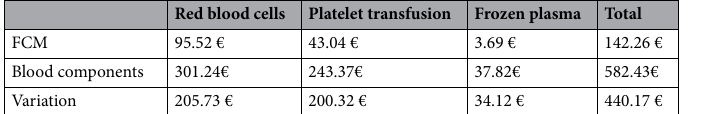
Table 7. Direct cost of ABTs.